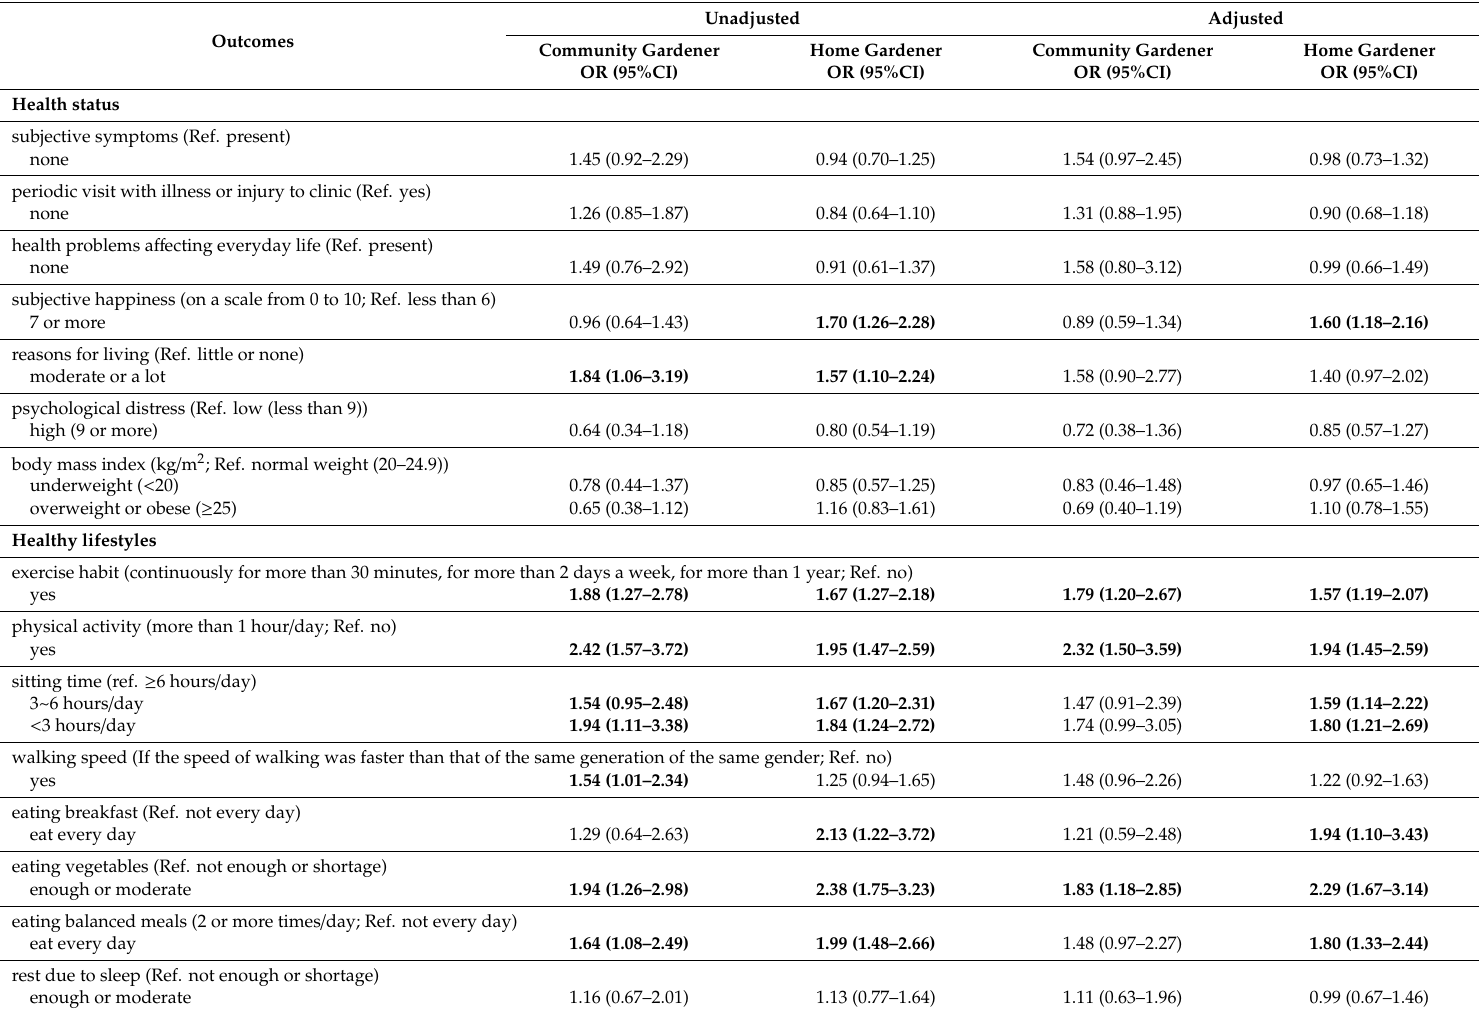
Table 2. Relationship between gardening and health status or healthy